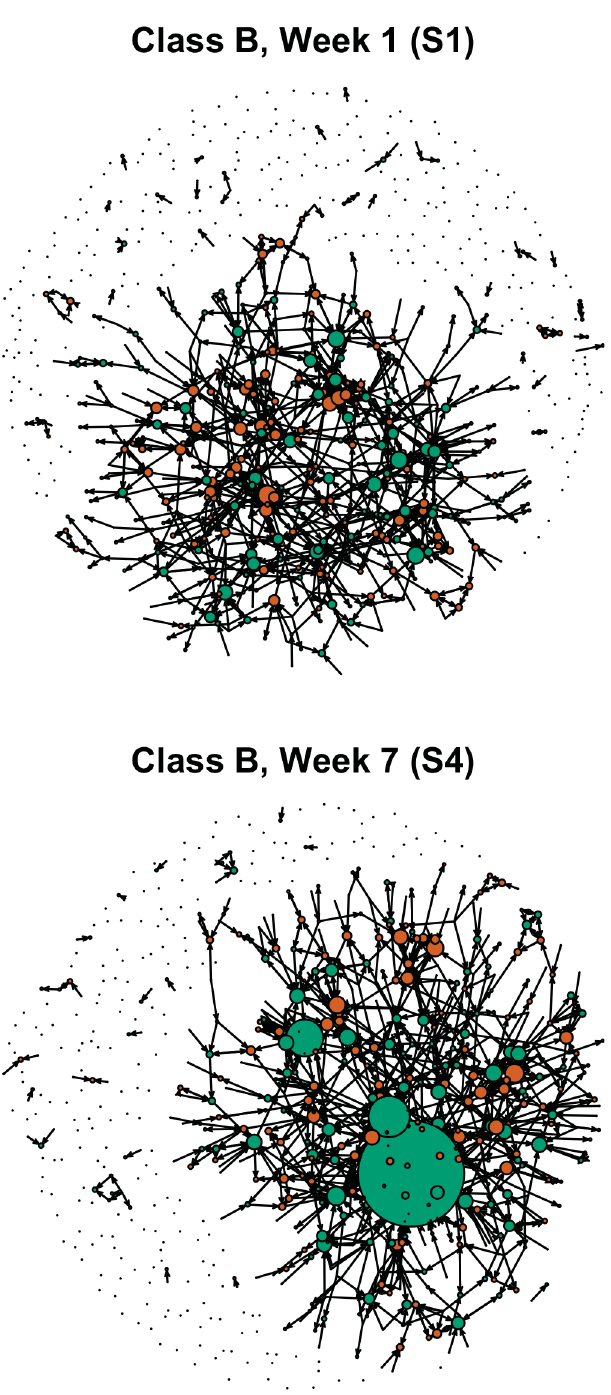
Fig 1. Unequal distribution of peer perception of mastery of content among genders grows over the term. Sociographs at the beginning of course (S1) and after exam 3 (S4) in class B. Male students are represented by green circles and females by orange circles. The size of nodes correlates with how many nominations each student received. Arrows show direction from the nominator to the nominee.